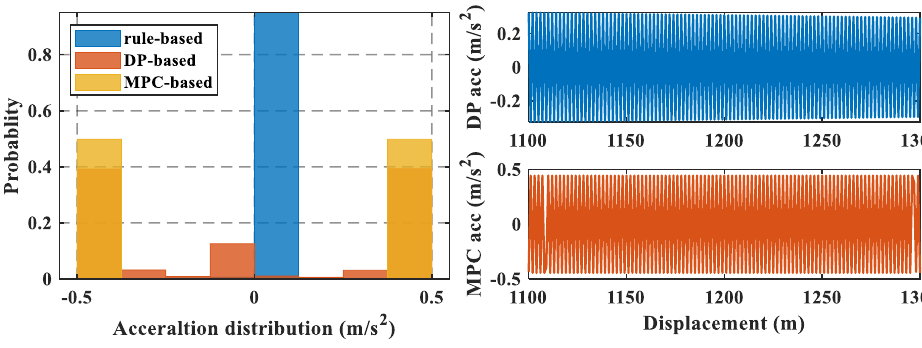
Figure 30. Acceleration of different EMSs.